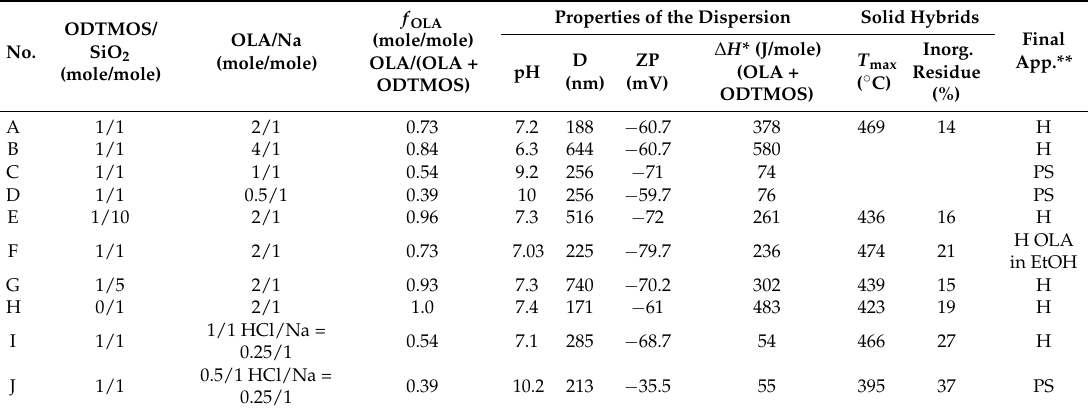
Synthesis conditions and the properties of dispersions obtained with octadecyltrimethoxysilane